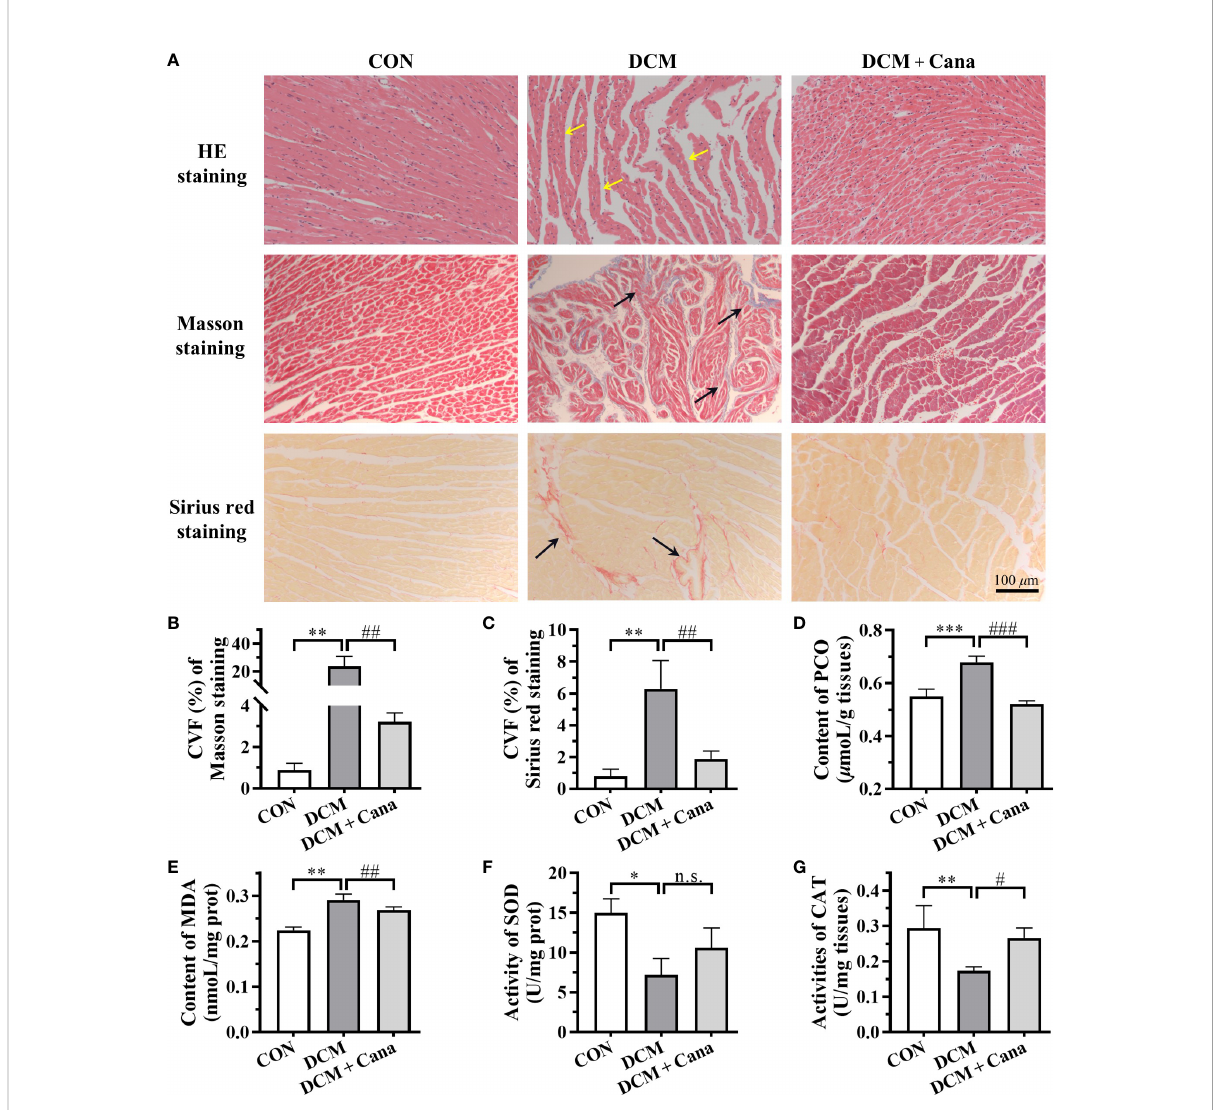
FIGURE 1 Canagli fl ozin inhibits oxidative stress and fi brosis in diabetic myocardial tissue (A) Pathological staining results of myocardial tissues (Scale bar: 100 µ m). (B) CVF of Masson staining. (C) CVF of Sirus red staining. Contents of (D) PCO and (E) MDA, activities of (F) SOD and (G) CAT in myocardial tissues. CVF, collagen volume fraction; PCO, protein carbonyl; MDA, malondialdehyde; SOD, superoxide dismutase; CAT, catalase. (*: P < 0.05; **: P < 0.01; ***: P < 0.001; compared with CON group; #: P < 0.05; ##: P < 0.01; ###: P < 0.001; compared with DCM group; n.s.: no signi fi